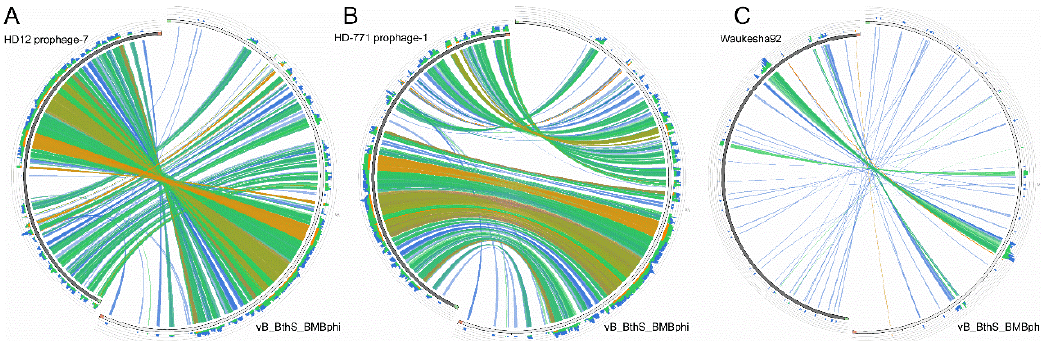
Figure 3. Comparative genomic analysis of phage vB_BthS_BMBphi. The genome sequences of phage vB_BthS_BMBphi, HD12 prophage-7 ( A ), HD-771 prophage-1 ( B ), and phage Waukesha92 ( C ), were compared and visualized by using Circoletto, and genome regions that exhibited similarity are shown in the same color. The degrees of similarities are also shown.